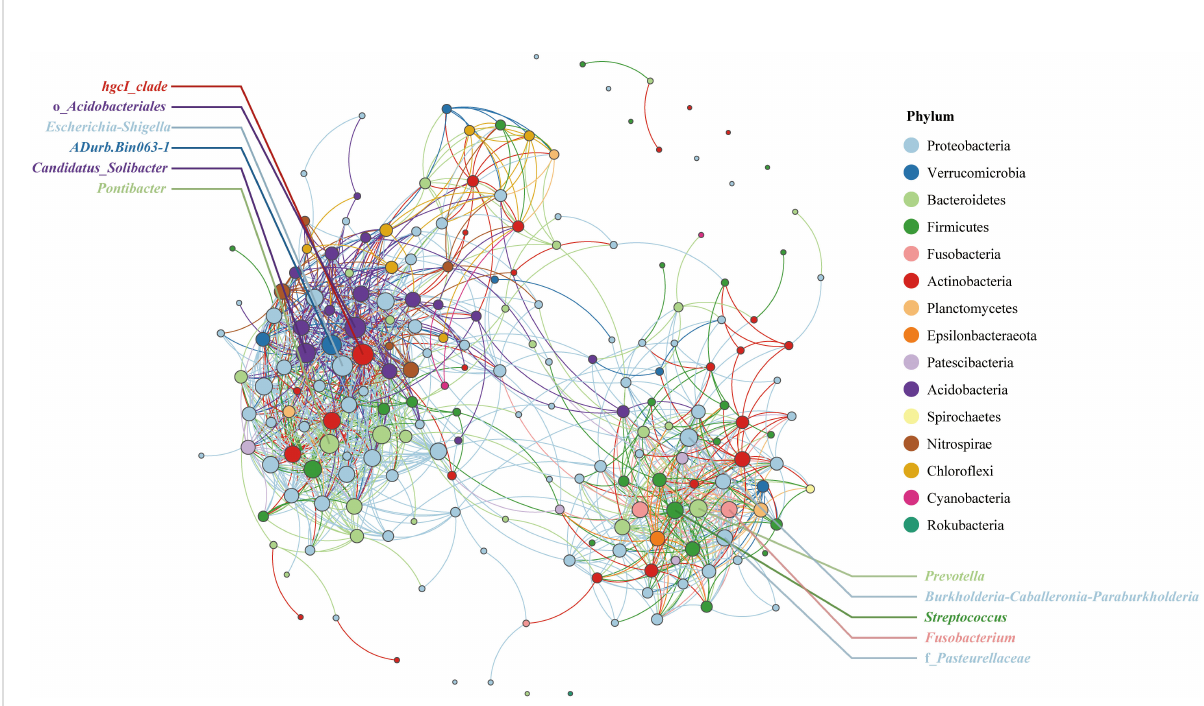
FIGURE 4 Correlation network analysis at the genus level of endophytic bacteria in qingke seeds. The node colors represent different bacterial phyla, and the node size is proportional to the